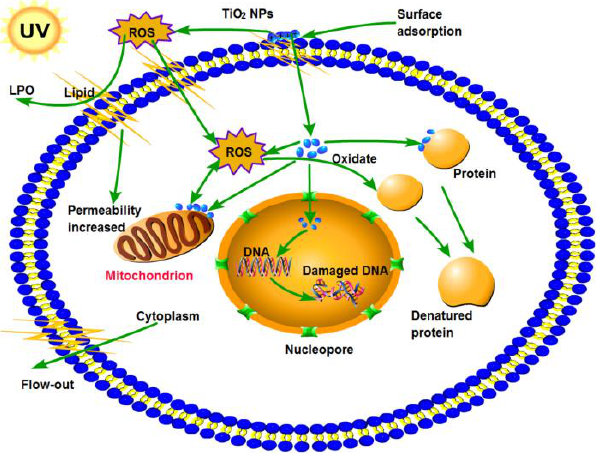
Figure 4. Schematic diagram showing the toxicity of TiO 2 NPs to microorganisms [103] . Reprinted with permission from [103] ; Copyright 2018 The Research Centre for Eco-Environmental Sciences, Chinese Academy of Sciences. Published by Elsevier B.V.